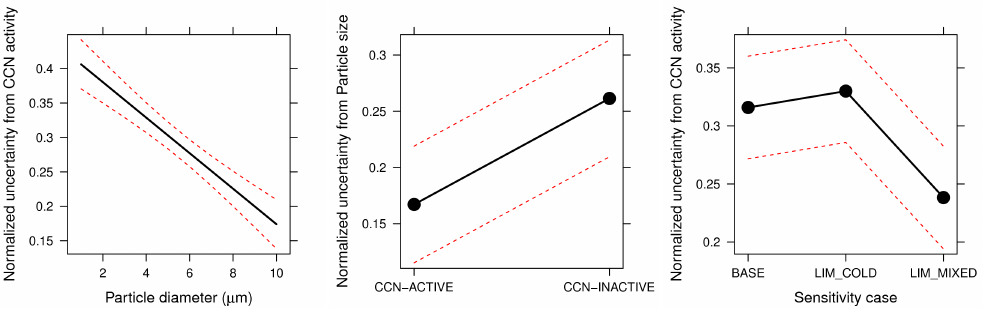
Fig. 9. Illustration of the marginal effects of model parameters on the model uncertainty, shown in linear effects plots following Fox (1987, 2003). Each plot shows the values predicted by a generalized linear model across the range of values of a main predictor variable, while other predictor variables are held constant at an average value. Left: effect of particle size on CCN uncertainty, controlling for IN sensitivity case. Middle: effect of CCN activity on size uncertainty, controlling for IN sensitivity case. Right: effect of sensitivity case on CCN uncertainty, controlling for CCN activity and size. Red dashed lines indicate the 95%-ile confidence interval.